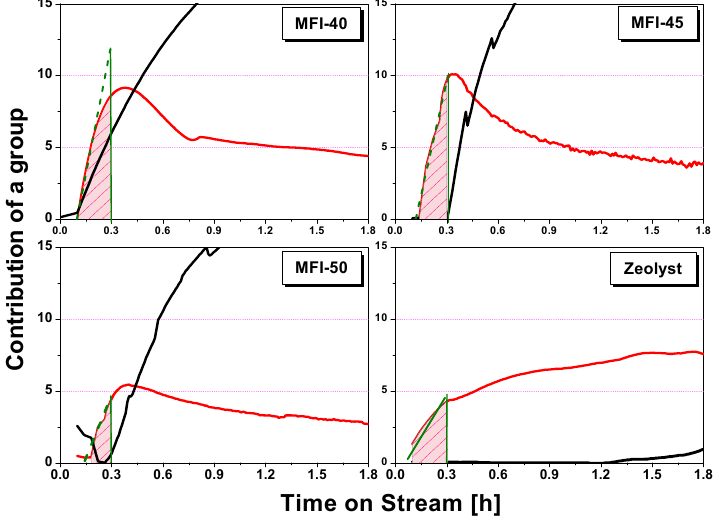
Figure 9. The evolution of intermediate species as a function of time; red represents the behavior of active species, while black represents the behavior of deactivated species.